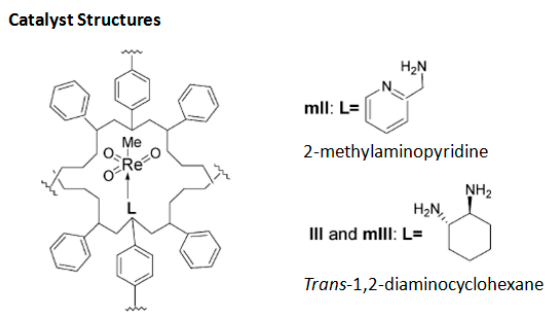
Table 5. Epoxidation of terpenic olefins by microencapsulated Lewis base of MTO a (adapted from reference [33]).